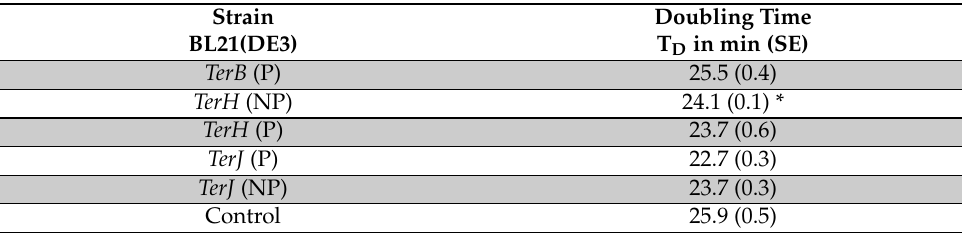
Table 1. Effect of ectopic Ter sites on the growth rate of E. coli